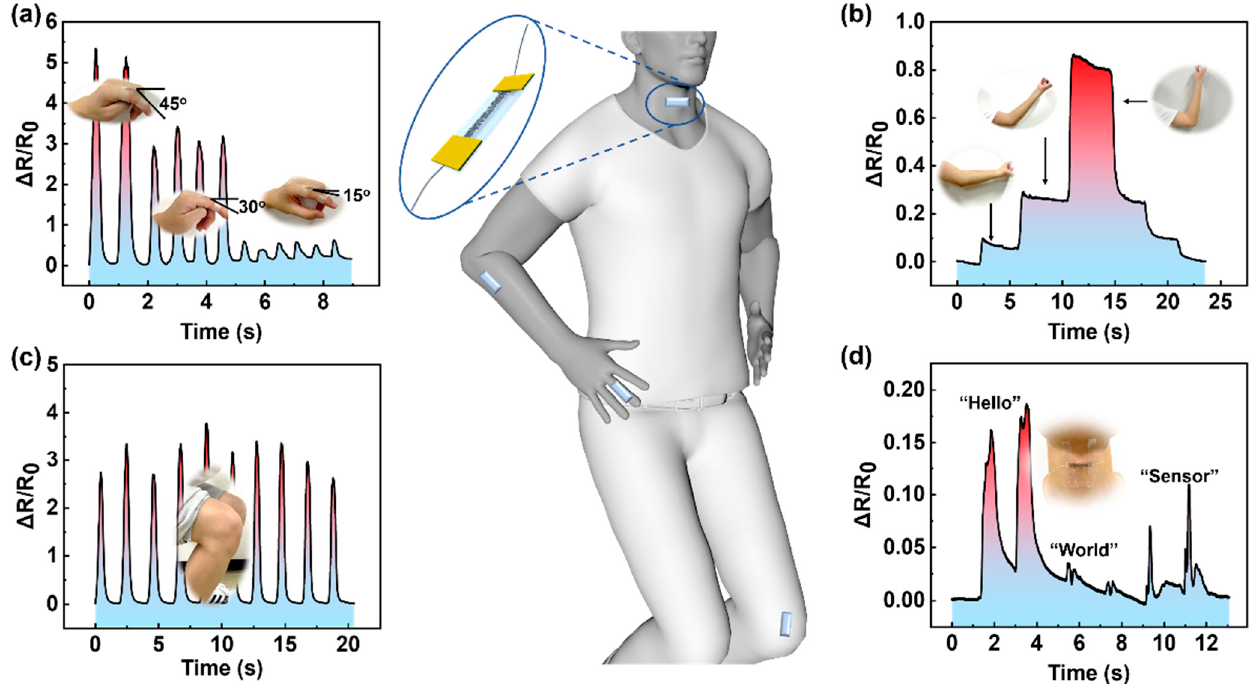
Figure 4. Wearable healthcare monitoring devices. ( a ) The relationship between change rate of resistance and finger bending degree with a strain sensor bonded to the finger joint. ( b, c ) The change rate of resistance varies with the joints movements of elbow and knee. ( d ) Demonstration of personal voice identification application.